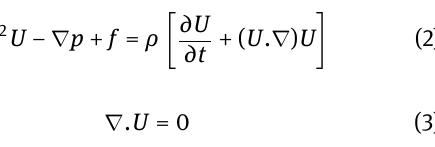
tions. The general equation in defining the movement